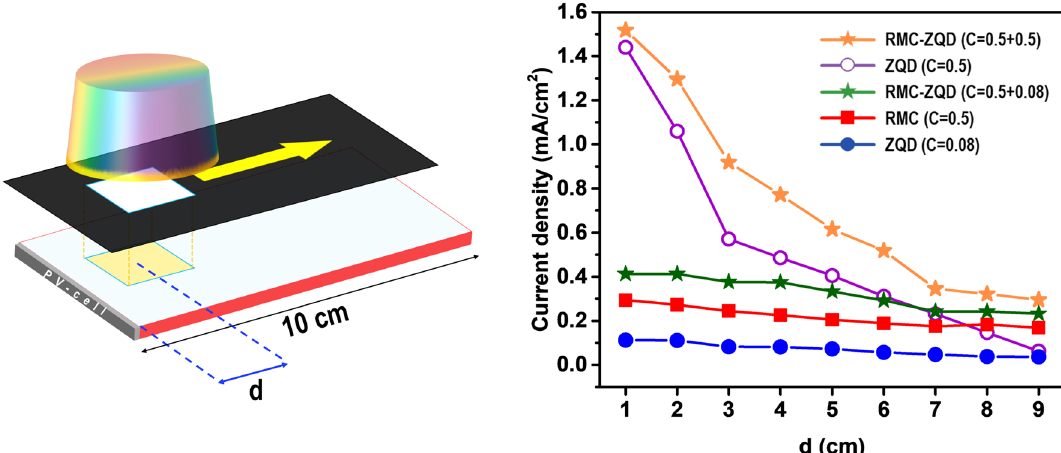
Figure 6. Schematic of the experiment for PV response of the LSCs as a function of distance between the PV cell and the excitation position. Current densities as a function of distance (d) were recorded on an excitation spot of area 2 cm × 2